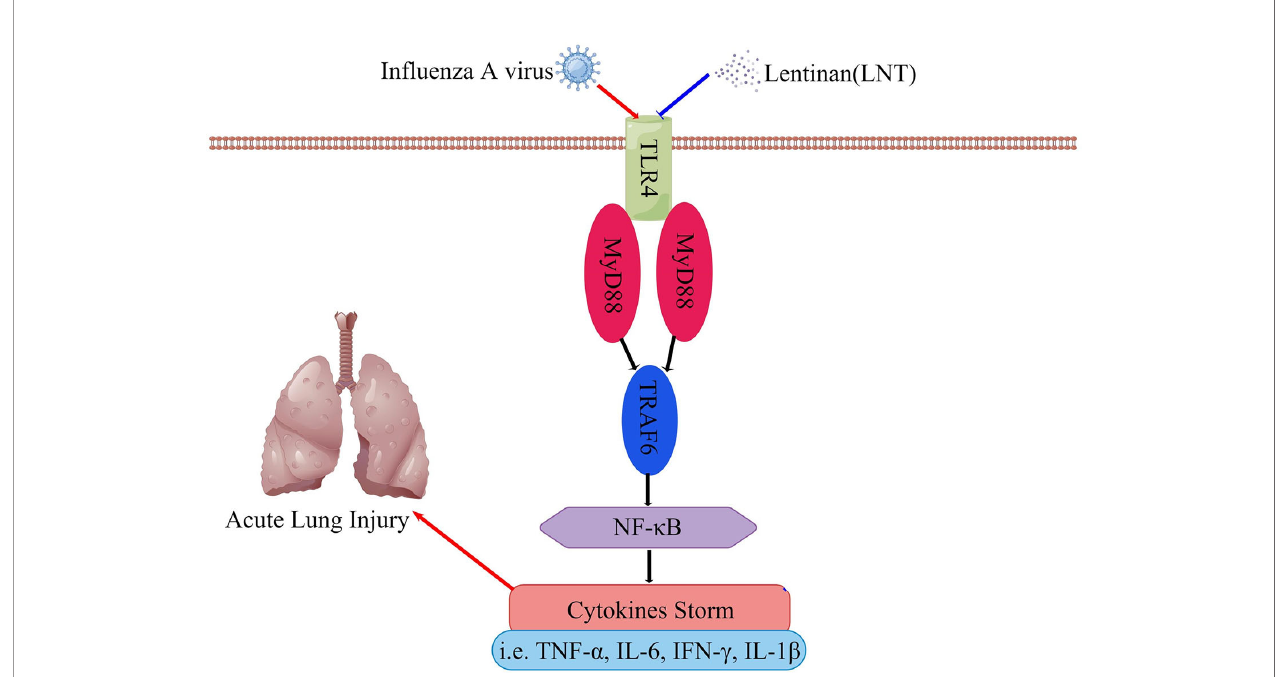
FIGURE 8 | LNT regulates the cytokine storm through the TLR4 signaling pathway and alleviates acute lung injury caused by in fl uenza virus infection. This fi gure was drawn on